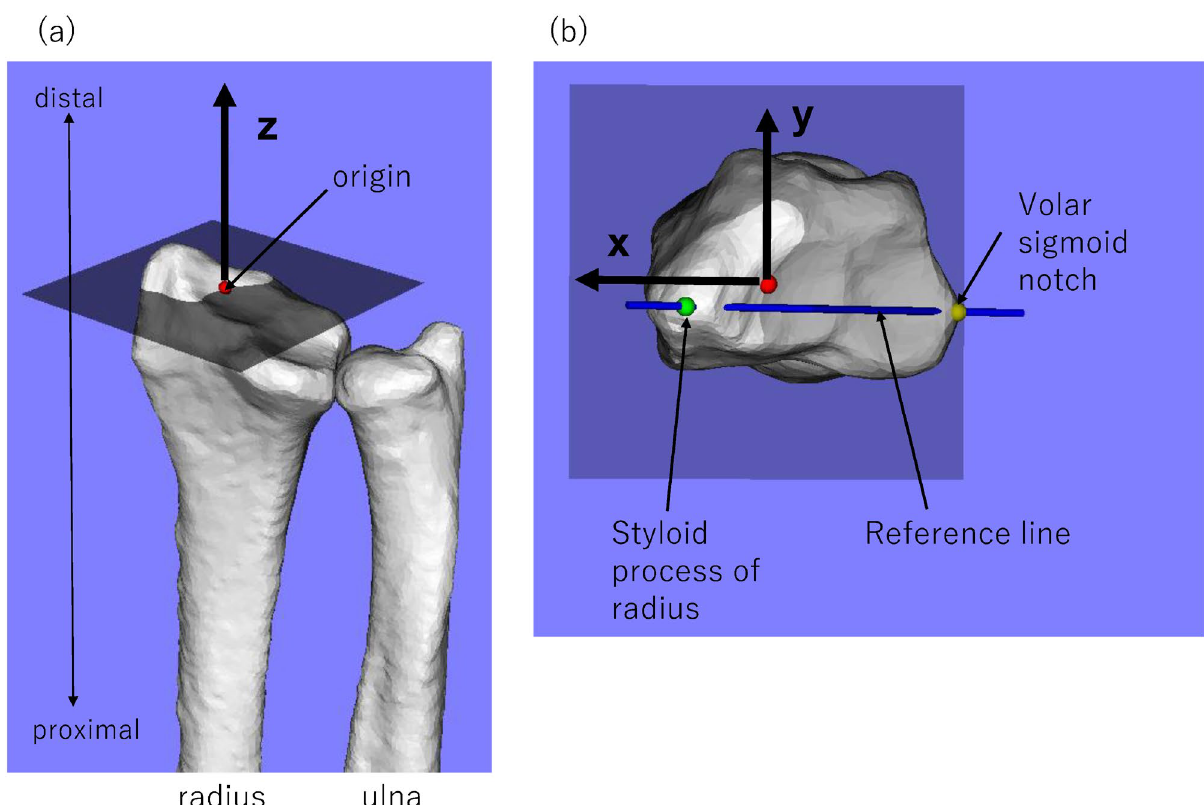
Figure 3. The relationship between image translation accuracy and 2D–3D reconstruction